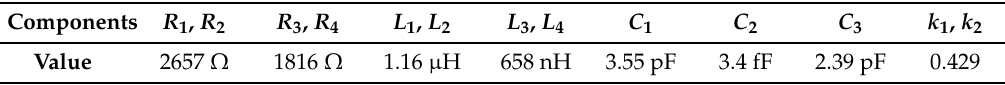
Figure 4. ( a ) Thicknesses ( d ) of metal layers used for the microtransformer construction; ( b ) A three-dimensional representation of the microtransformer windings. The same layer coloring is used in both figures. Table 1. The components’ values for the model circuit presented in Figure